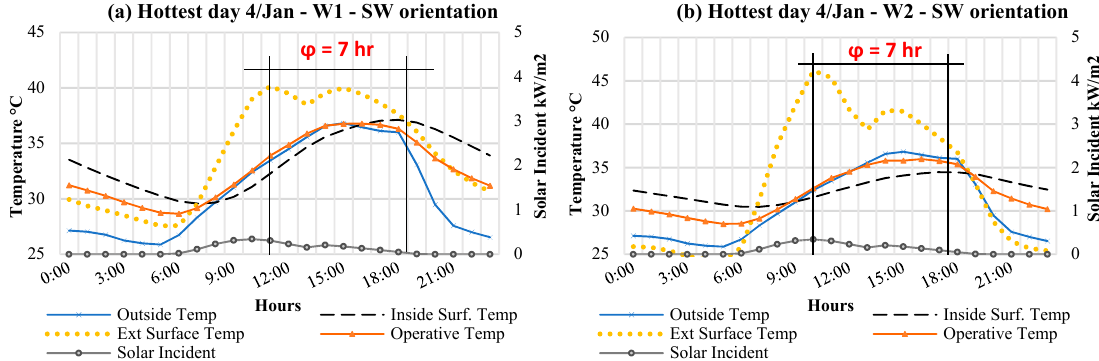
Figure 10. Surface temperatures for the wall with SW orientation in the original state W1 (a) and the solution W2 (b).